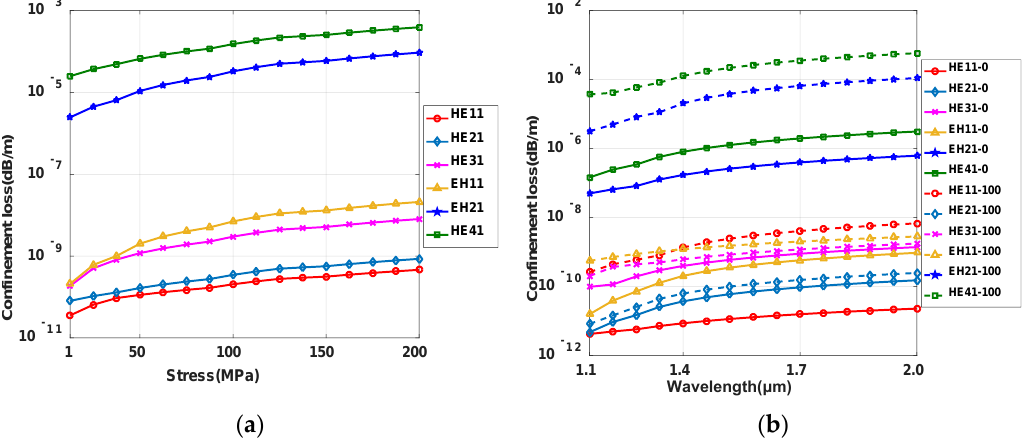
Figure 14. ( a ) Confinement loss as a function of stress for different modes, and ( b ) confinement loss as a function of length for different modes under 100 MPa stress in the y direction.